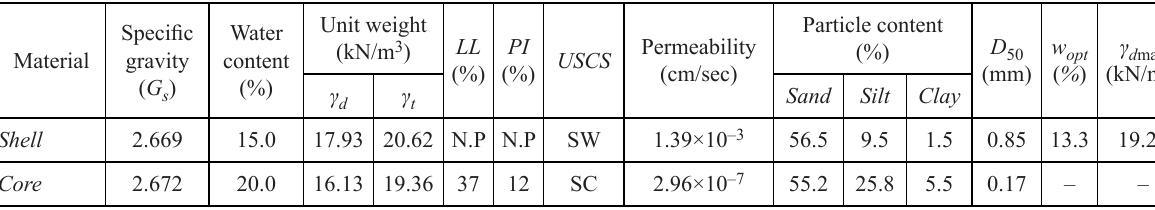
Table 1. Material properties of shell and core